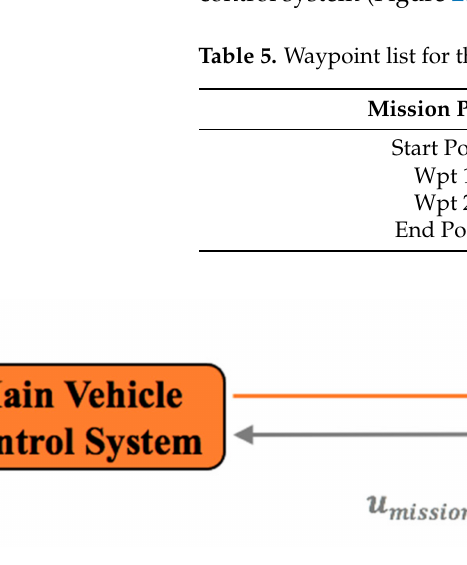
Figure 21. Exchange of data between the main vehicle control system and the waypoint controller when the glider changed its target points